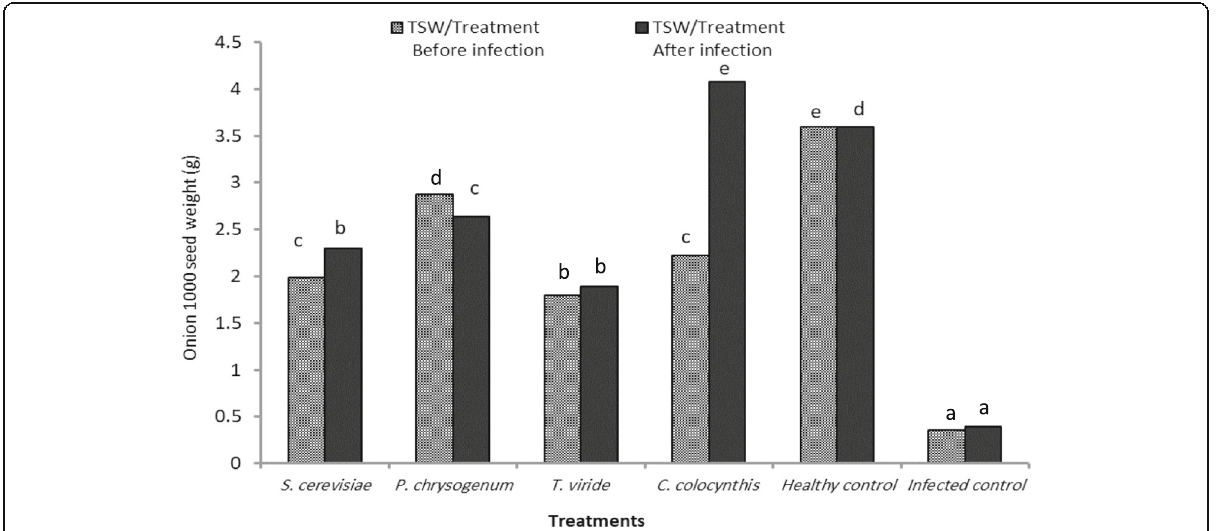
Fig. 1 Effect of treatments on weight of onion seeds. Columns in the same color having the same letter are not significantly different at P ≤ 0.05